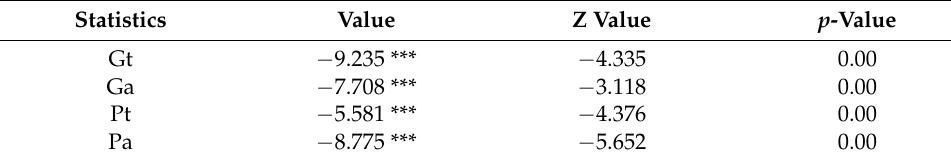
Table 6. The findings of the Westerlund cointegration